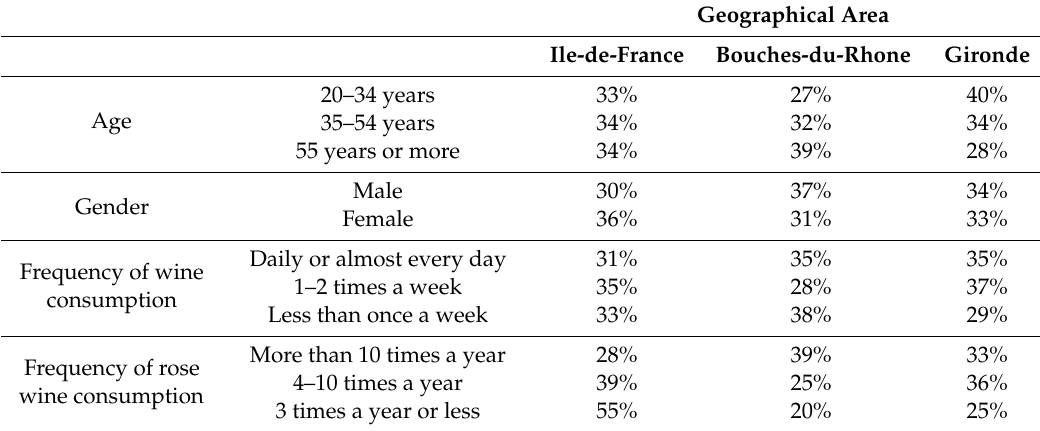
Table 1. Structure of the panel by geographical area.